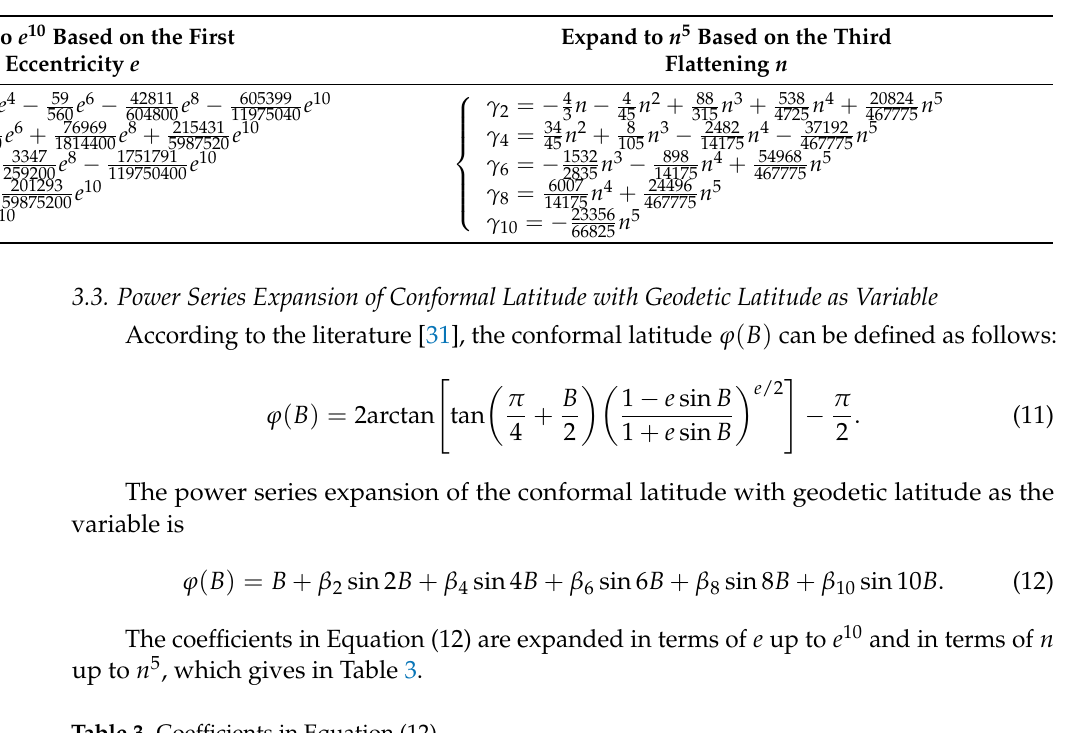
Table 2. Coefficients in Equation (10).